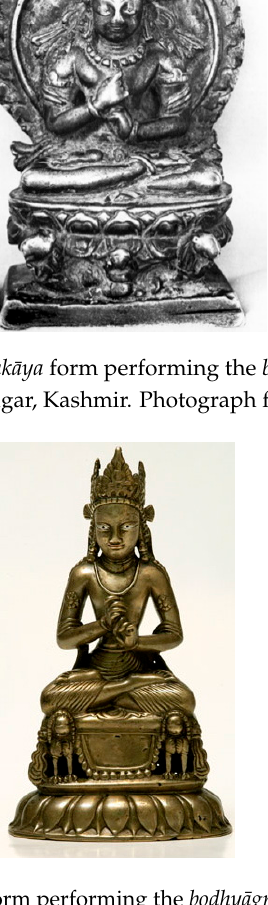
Figure 27. Vairocana in sambhogak ā ya form performing the bodhy ā gr ī mudr ā , seventh c. Swat. Brass with silver inlay eyes and copper inlay lips, 19 cm H. https://himalayanbuddhistart.files.wordpress.com/2012/10/7th-c-swat-valley-vairocana-brasssil- inlay-19-cm-rossi.jpg.